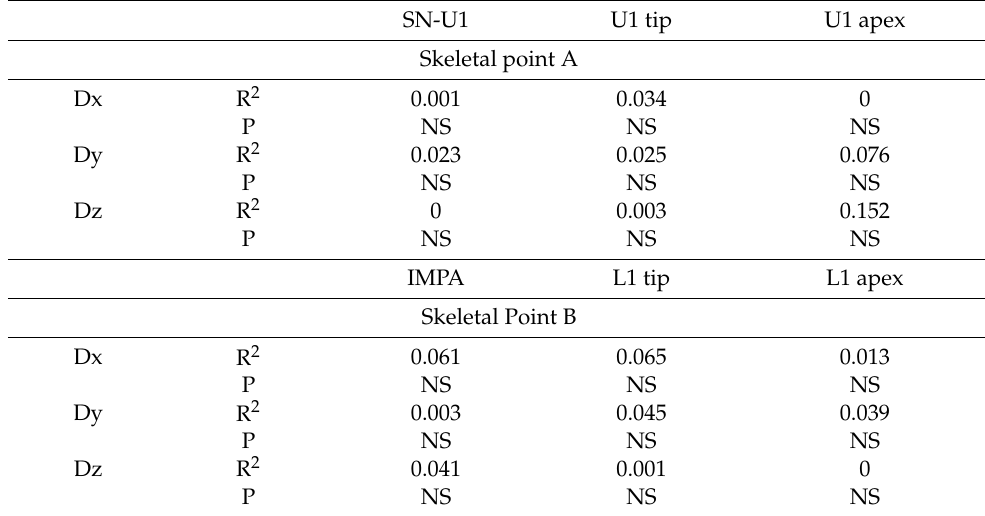
Table 3. The coefficient of correlation and p -values between incisal movements and skeletal points A and B